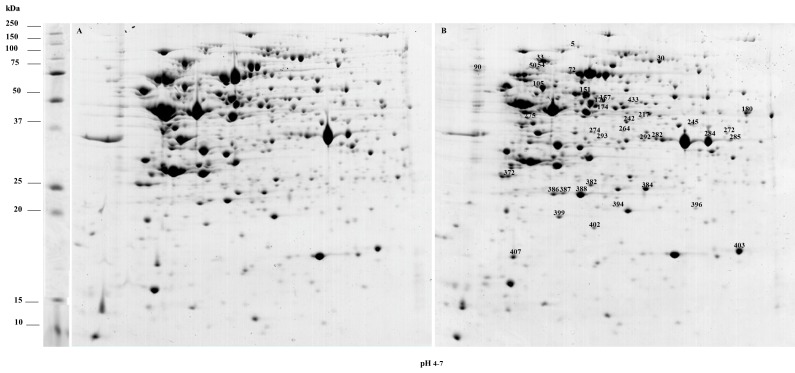
Representative 2-DE gels of L. acidophilus proteome.(A) 2-DE gel obtained from the proteome of L. acidophilus grown under control conditions. (B) 2-DE gel obtained from the proteome of L. acidophilus grown in the presence of rutin. Spots exhibiting significant differences in mean intensities are indicated.